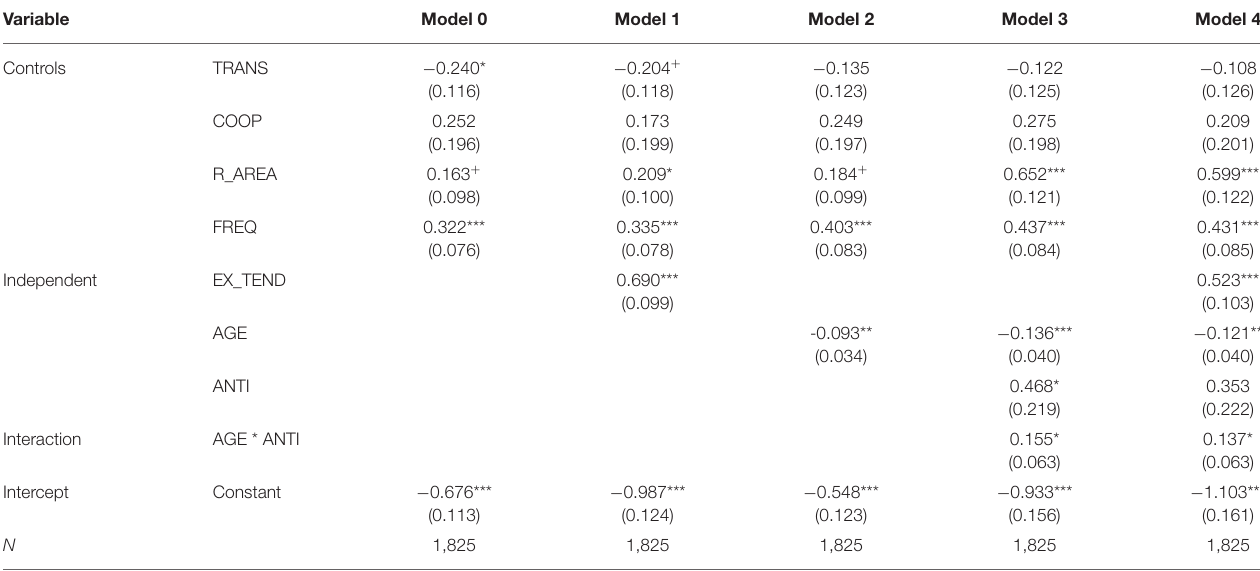
TABLE 4 | Results of logistic regression analysis.